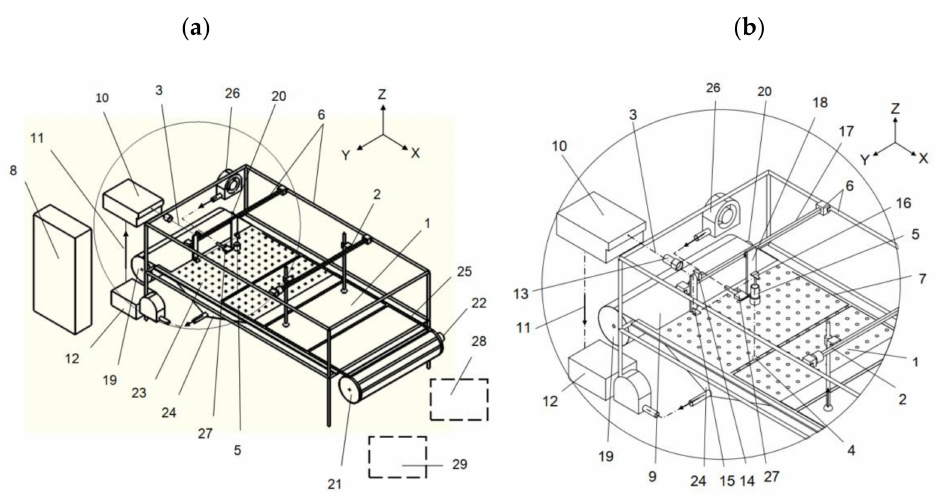
Figure1. Diagramofthestandforcuttinglabelsfromamultilayerpolypropylenefilmduringproduction of in-mold labelling (IML) ( a ) and a view of a movable system based on a plotter for ultraviolet